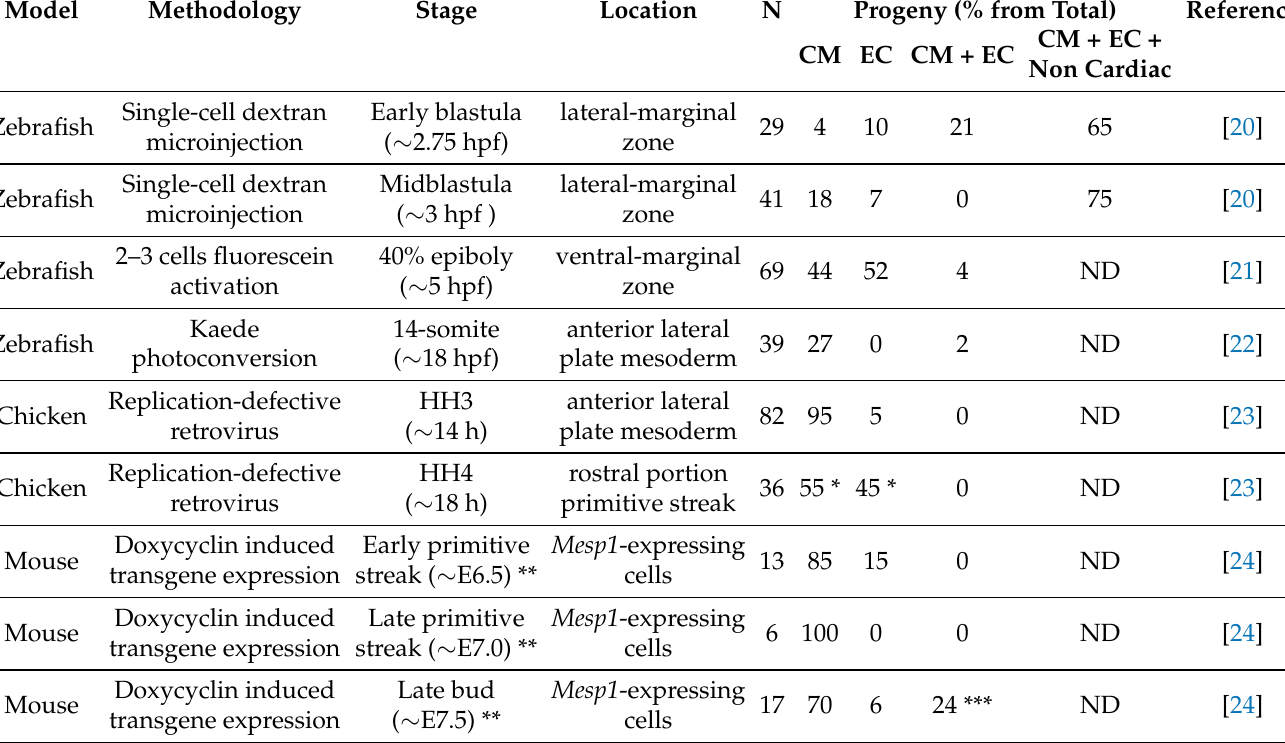
Table 1. Clonal analysis studies assessing early cardiac lineage segregation in vertebrate models.